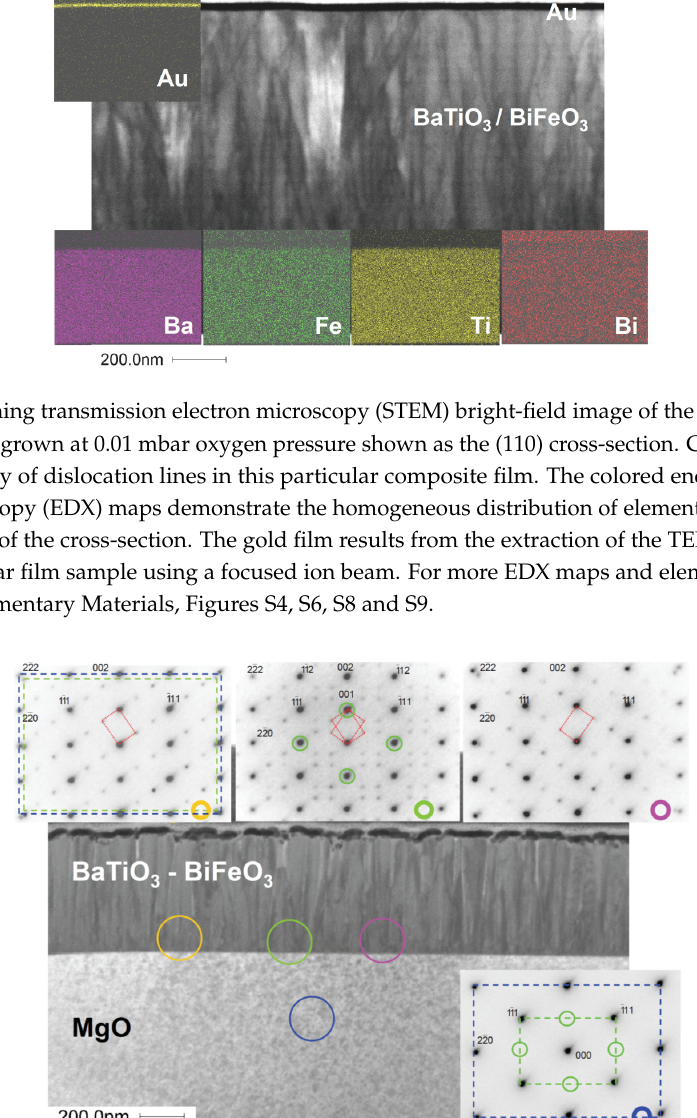
Figure 5. STEM dark ‐ field image of the BaTiO 3 ‐ BiFeO 3 composite film grown at 0.25 mbar on MgO(001) taken from the (110) cross ‐ section. The four selected area electron diffraction (SAED) patterns have been taken from the encircled regions at the interface or the substrate. The main spots from the composite (green circles) confirm the BaTiO 3 ‐ type structure of the composite film. These are forbidden for MgO, as seen bottom right. The additional weak spots in the composite indicate superstructure reflections that are probably due to oxygen vacancy ordering. The red dotted lines show the two possible orientations of oxygen vacancy ordering.